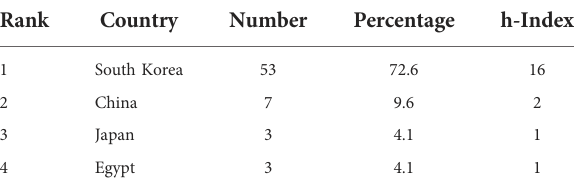
TABLE 1 The most productive countries/regions contributed to research publications in the fi eld of unilateral biportal endoscopic spine surgery.